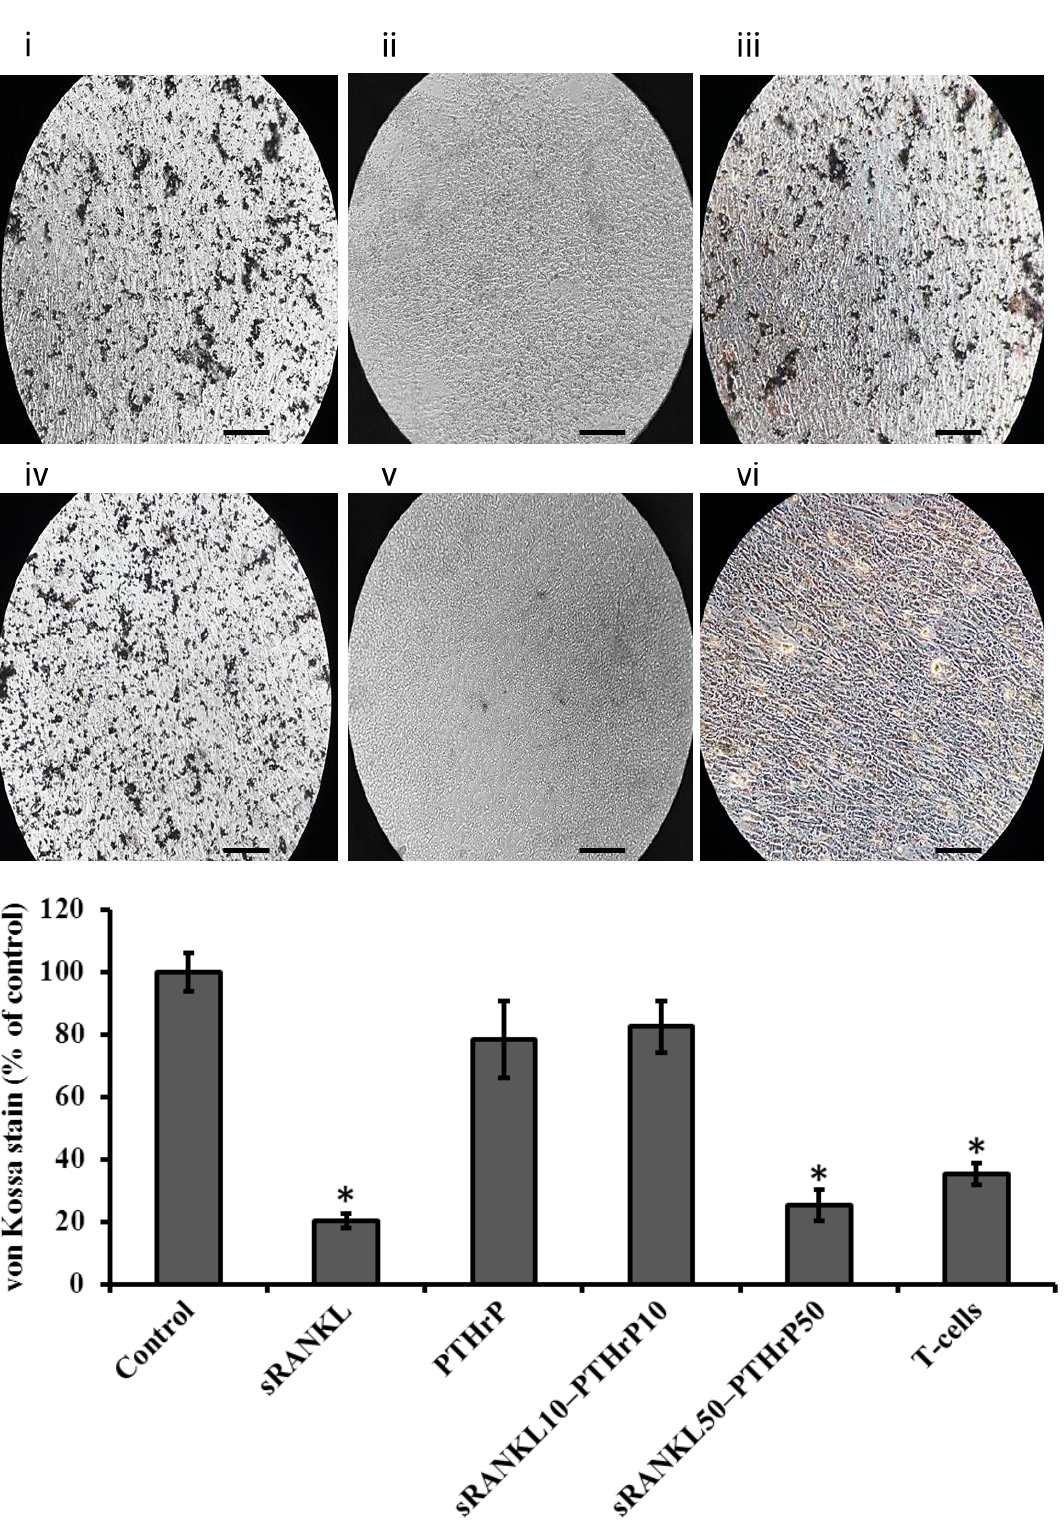
( ii ) sRANKL, ( iii ) PTHrP10, ( iv ) sRANKL10–PTH10, ( v ) sRANKL50–PTHrP50, ( vi ) T-cells-MSCs, Figure 9. The level of von Kossa staining of differentiated MSCs by sRANKL and PTHrP. (i) control, scale bars: 0.1 cm. * p < 0.05 vs. (ii) sRANKL, (iii) PTHrP10, (iv) sRANKL10 – PTH10, (v) sRANKL50 – PTHrP50, (vi) T-cells-MSCs, scale bars: 0.1 cm. * p < 0.05 vs. control.